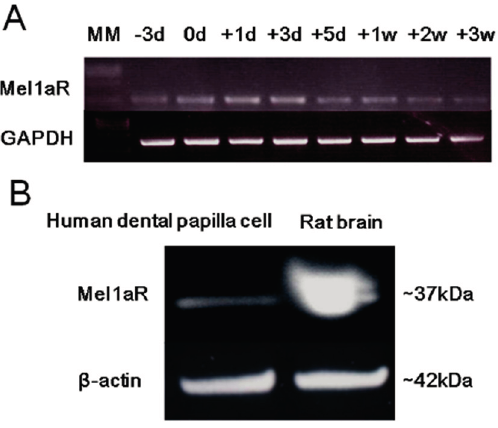
Figure 3. ( A ) The expression of mRNA for Mel1aR in DP-805 cells (a human dental papilla cell line). Mel1aR mRNA expression was detected at 3 days of culture before reaching confluence ( − 3d), gradually increased until 3 days after reaching confluence (+3d), and gradually decreased thereafter until 3 weeks of culture (+3W); and ( B ) Expression of Mel1aR protein in DP-805 cells. DP-805 cells were cultured until reaching confluence. Thereafter, the expression of Mel1aR protein was analyzed by Western blot. A major band for Mel1aR was observed at ~37 kDa. The amount of protein loaded for DP-805 cells and rat brain was 80 and 100 µg,